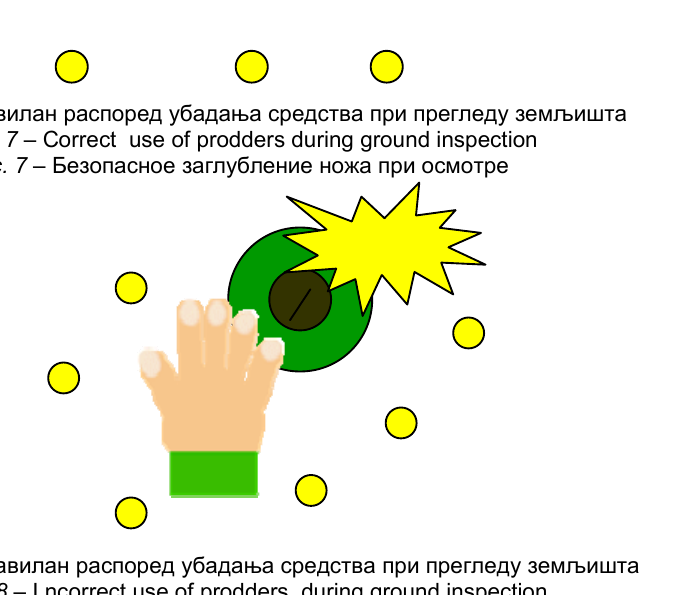
Figure 8 – I ncorrect use of prodders during ground